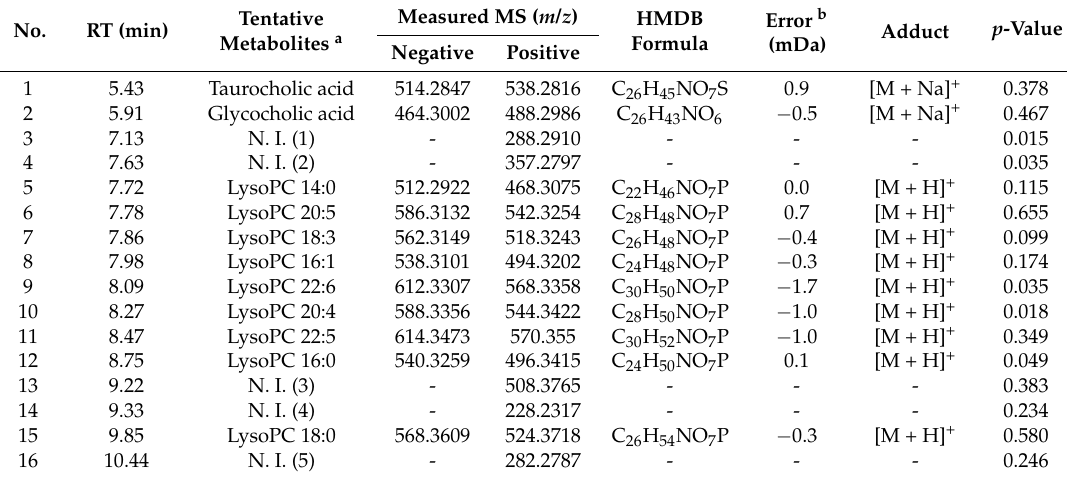
Table 3. Discriminant plasma metabolites identified using UPLC-Q-TOF-MS in different rat groups.